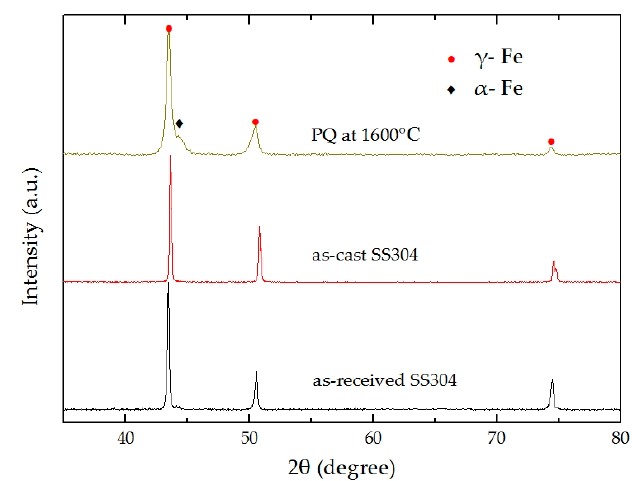
Figure 2. X-ray diffraction (XRD) spectra of the as-received SS304, as-cast SS304 and PQ SS304.